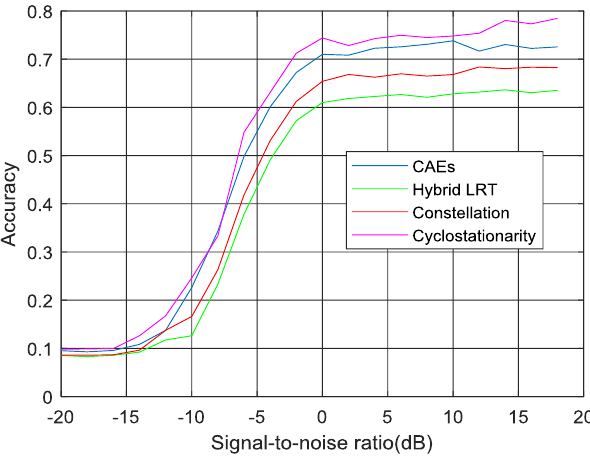
Figure 10. AMR performance for different signal-to-noise ratios (SNRs).